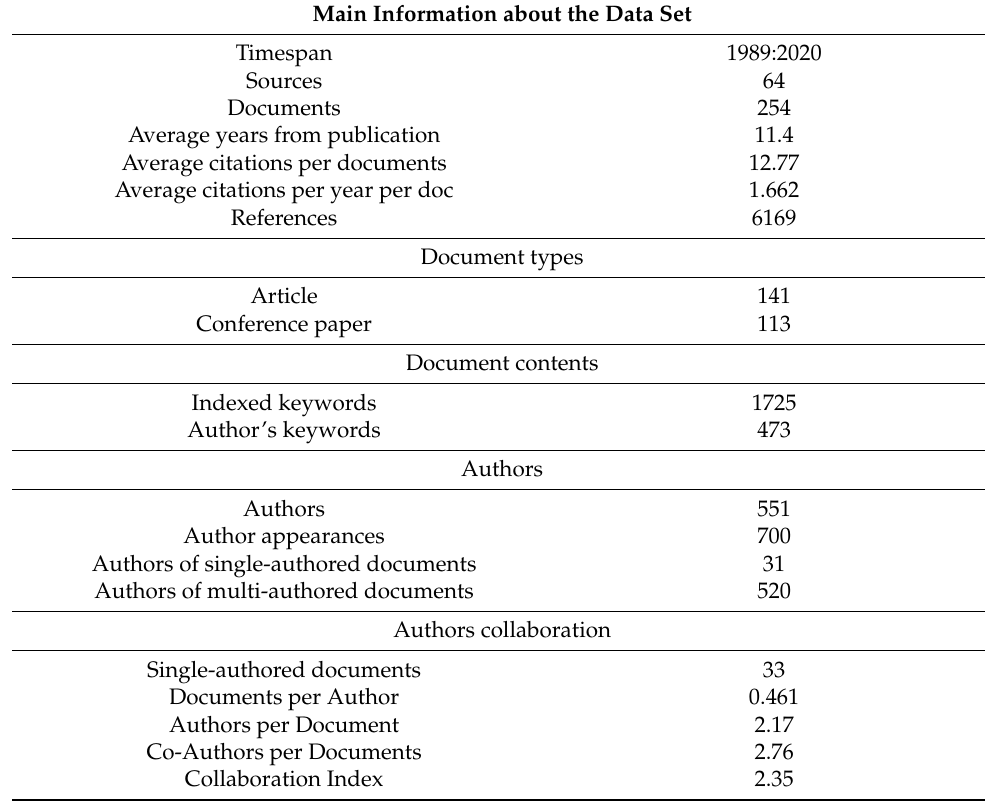
Table 3. Descriptive information about the dataset. Main Information about the Data